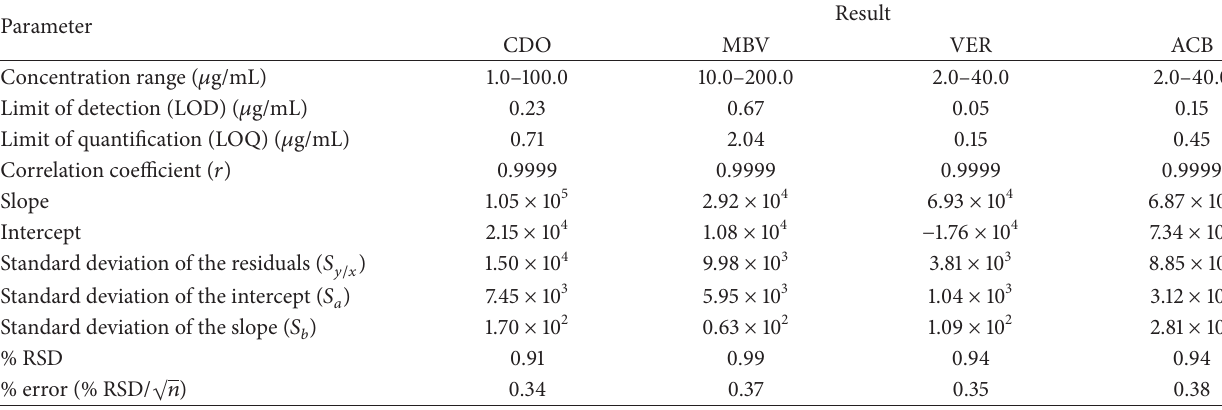
Table 1: Analytical performance data for determination of CDO, MBV, VER, and ACB by the proposed method.